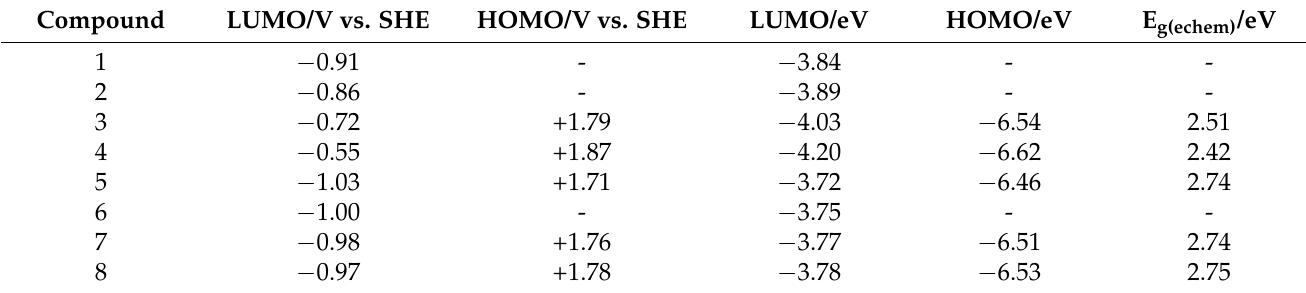
Table 3. Oxidation and reduction potentials and frontier molecular orbitals (FMO) levels obtained by the electrochemi- cal measurements.